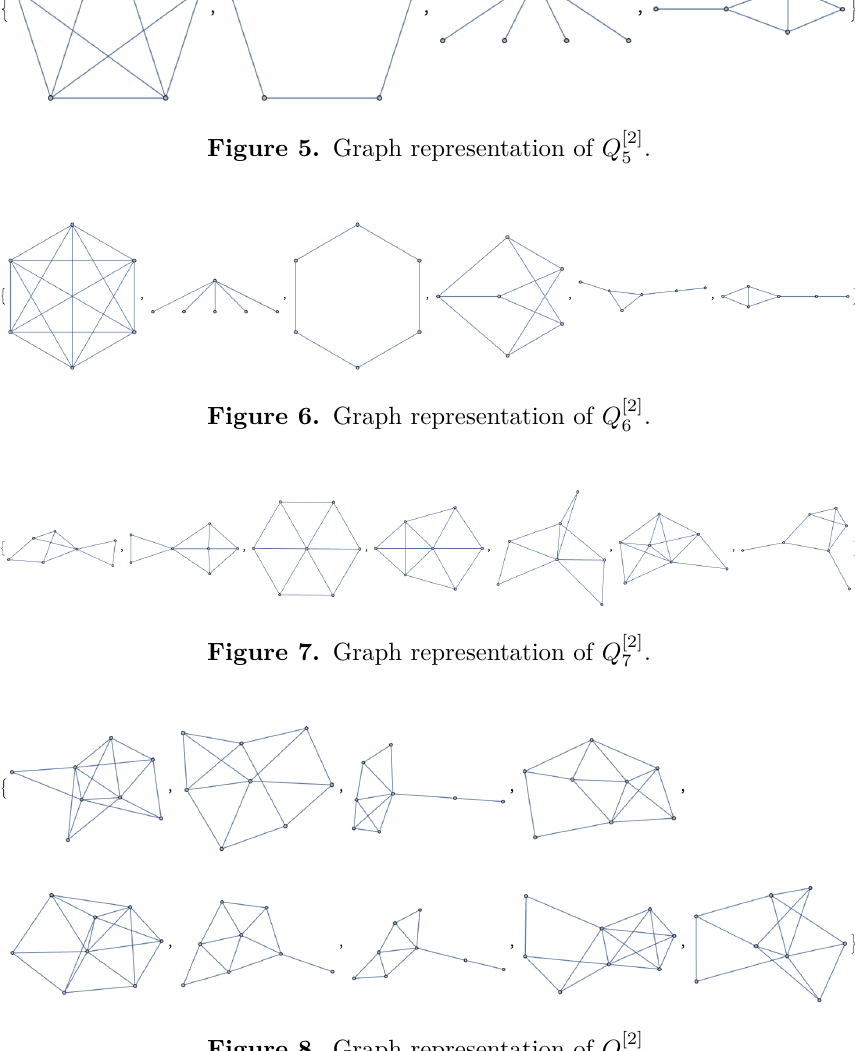
Figure 8. Graph representation of Q [2]